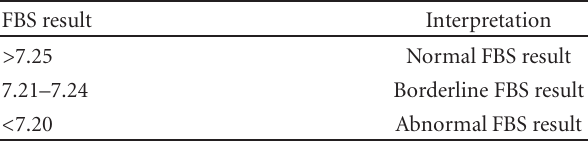
Table 2: Interpretation of fetal blood sample (FBS)